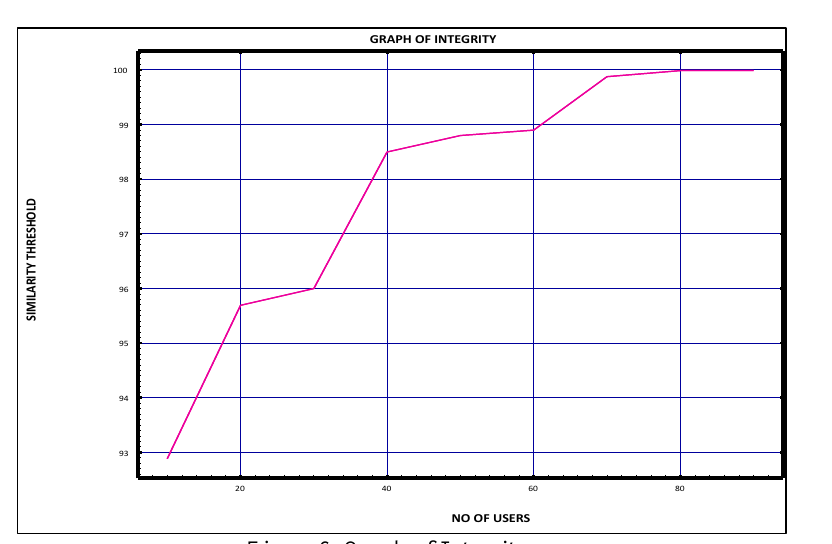
Figure 6: Graph of